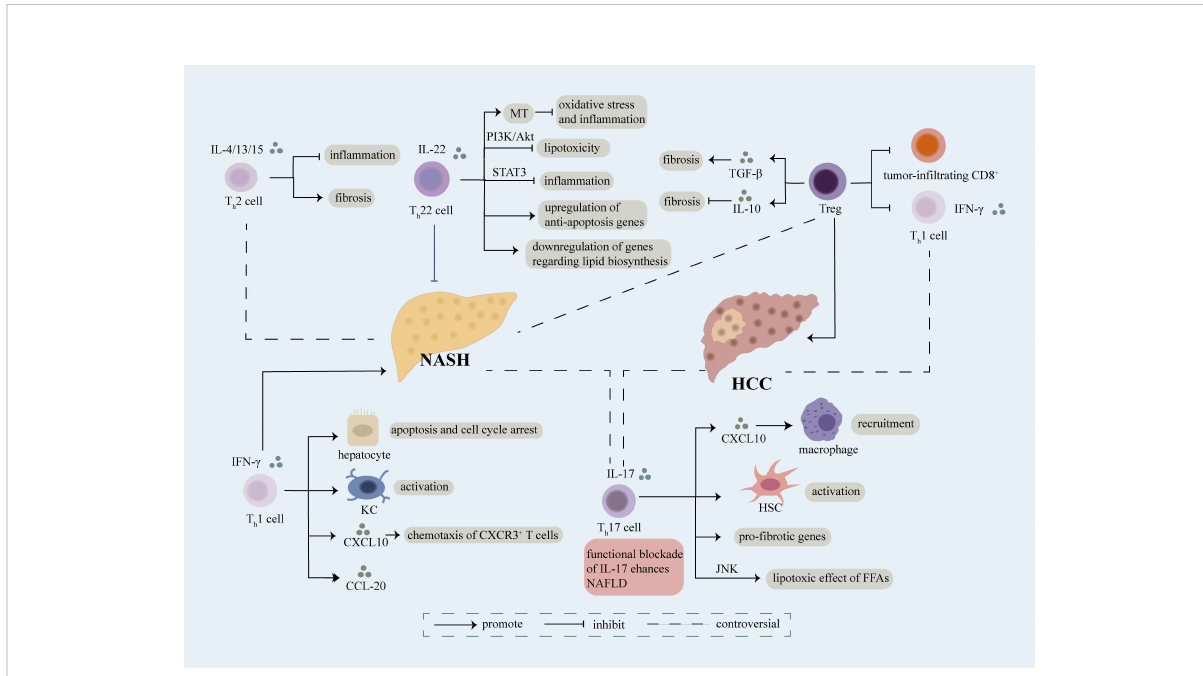
FIGURE 1 Role of CD4 + T cell. Different sets of CD4 + T cells including Th1, Th2, Th17, Th22, Treg cells involve in the regulation of NASH and NASH- induced HCC mainly through secretion of cytokines and interaction with other cells. Th1 cells are featured with secretion of IFN- g , which can further induce apoptosis and cell cycle arrest of hepatocyte, activation of kupffer cells (KCs), production of CXCL20 and chemotaxis of CXCR3 + T cells in a CXCL10-dependent manner, thus accelerating the evolution of NASH. The exact role of Th2 cells releasing IL-4/13/15 in